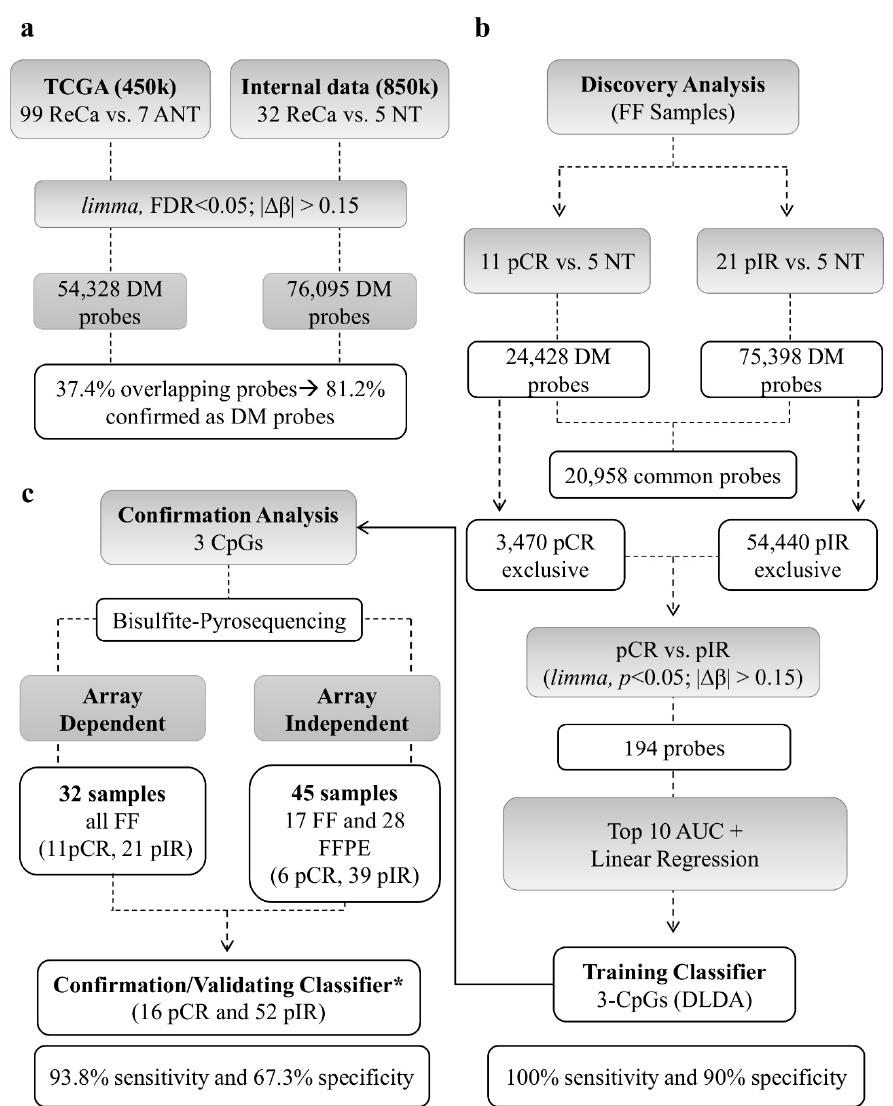
Figure 2. Sequential steps used to develop the DNA methylation classifier to predict neoadjuvant chemoradiotherapy (nCRT) response in rectal cancer (ReCa). ( a ) The methylation status of 99 ReCa